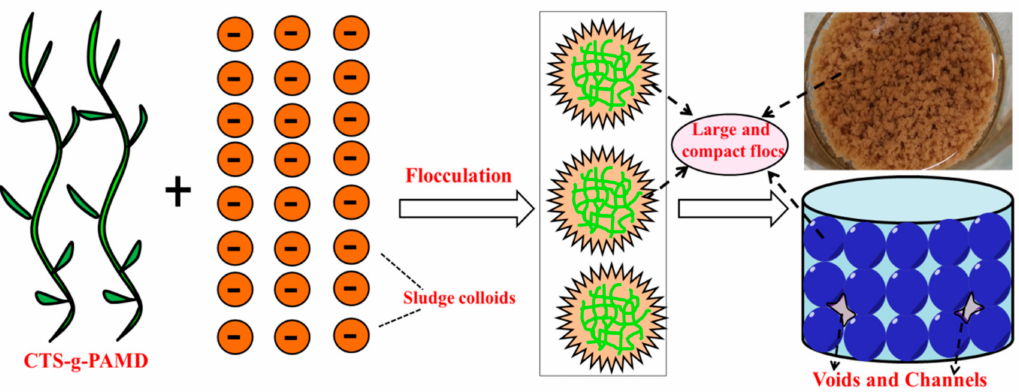
Figure 12. The flocculation mechanism of the